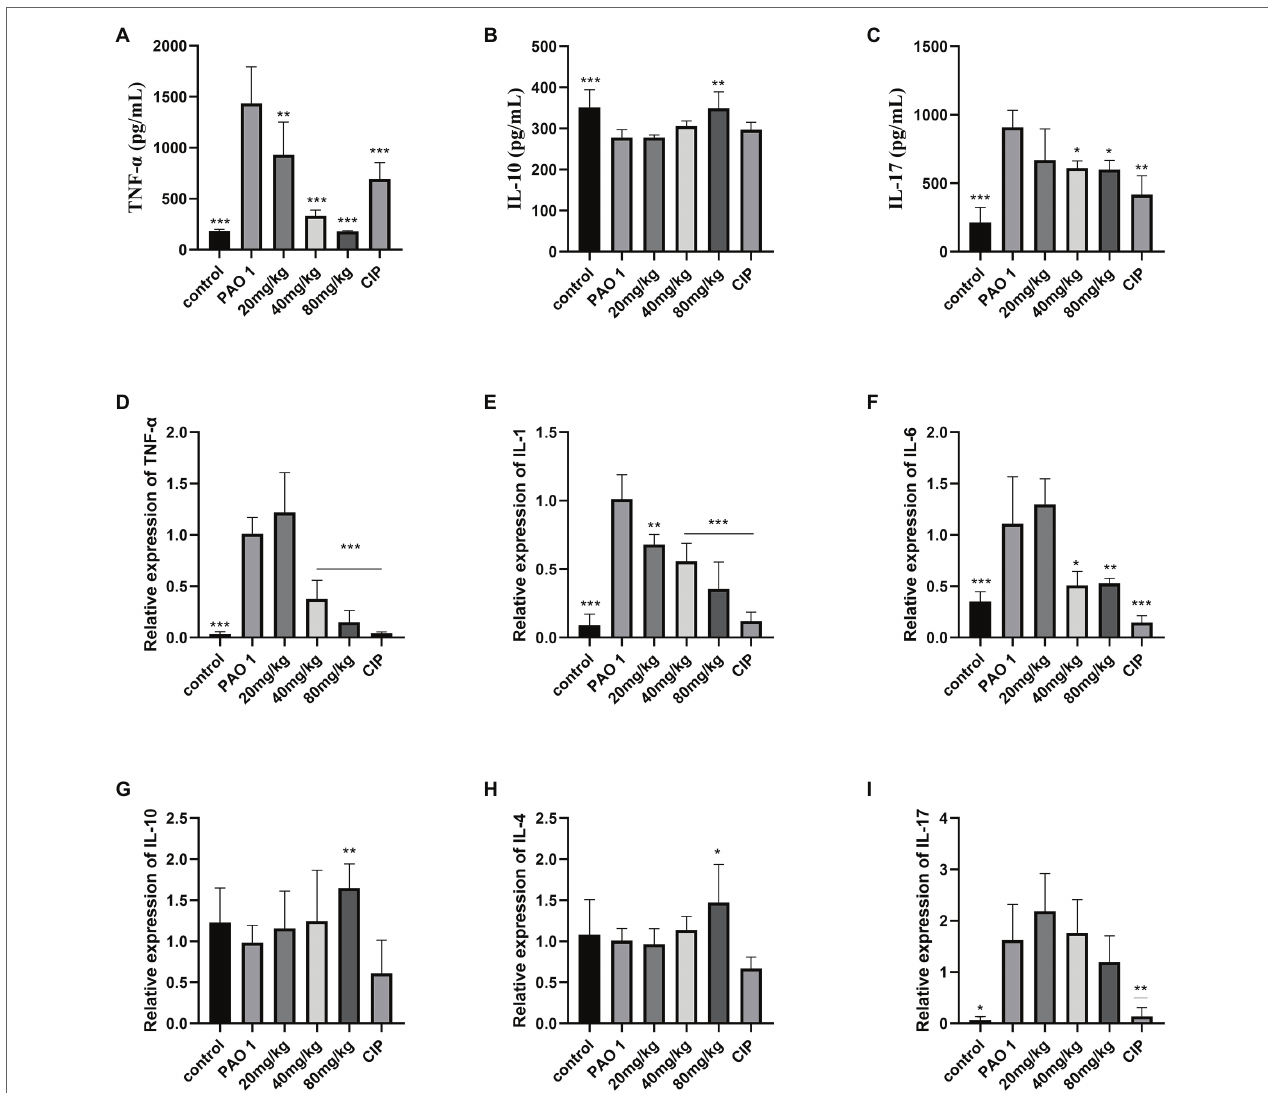
FIGURE 5 | Assay of inflammatory cytokines by ELISA and QRT-PCR. Secreted TNF- α , IL-10, and IL-17 from the bronchial-alveolar lavage fluid was assessed by ELISA assay kit (A–C) . EGCG affected the expression of cytokines with a dosage dependent manner in the lung (D–I) . Data are presented as mean ± SD and analyzed with one-way ANOVA. * p < 0.05, ** p < 0.01, *** p < 0.005 vs. PAO 1